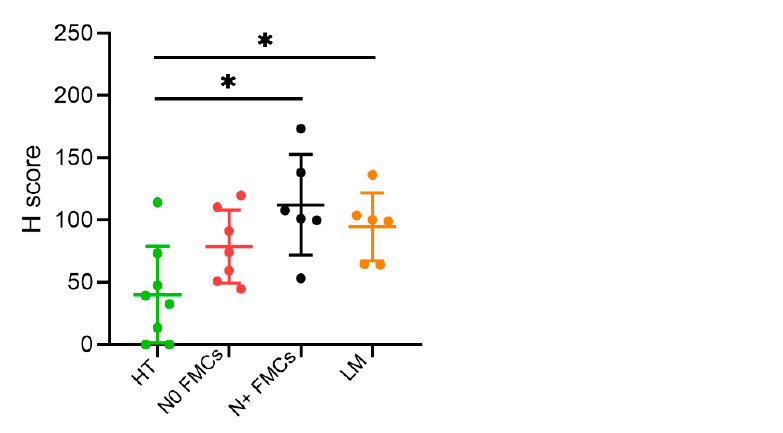
Figure 2. H-score of TFR-1 protein expression. H-score value of 27 samples of feline mammary gland tissue: healthy tissue (HT) ( n = 8, green) (mean 40.07 ± SD 38.95), feline mammary carcinoma without lymph node metastasis (N0 FMCs) ( n = 7, red) (mean 78.72 ± SD 29.41), feline mammary carcinoma with lymph node metastasis (N+ FMCs) ( n = 6, black) (mean 112.28 ± SD 40.51), and lymph node metastasis (LM) ( n = 6, orange) (mean 99.48 ± SD 27.95). The H-score value was significantly higher in N+ FMCs and in LM as compared to HT (* p < 0.05).